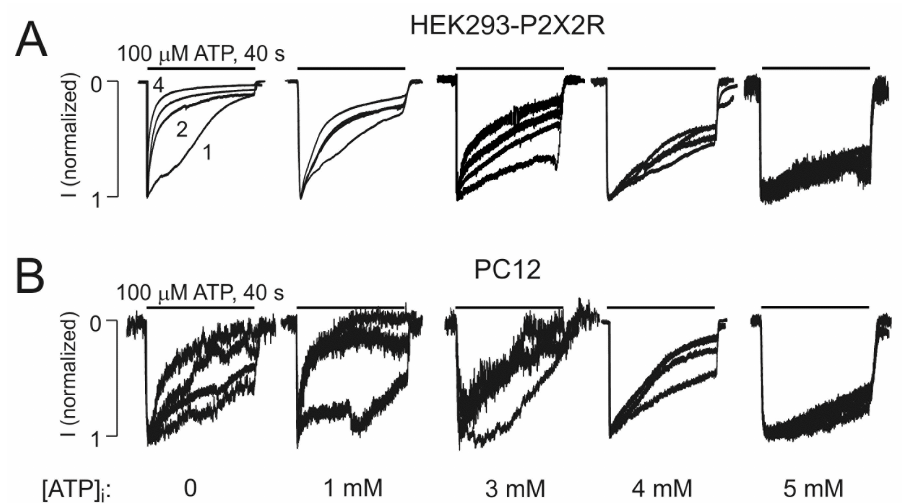
Figure 7. Intracellular ATP concentration-response experiments. ( A , B ) Traces of currents induced by repetitive application of 100 µ M ATP for 40 s with 4 min washout periods for cells bathed in calcium-containing medium with the intracellular solution containing 0, 1, 3, 4 or 5 mM ATP in HEK293 cells transfected with the P2X2R cDNA ( A ) or in PC12 cells ( B ) that endogenously express the P2X2R. Recordings were performed in at least three different cells for each condition.